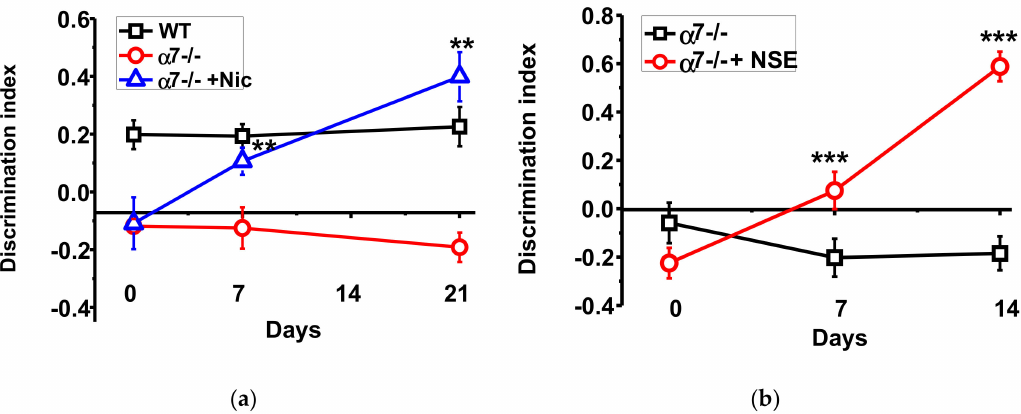
Figure 1. Memory (discrimination index studied in NOR test) of α 7- / - mice under the e ff ect of either nicotine ( a ) or NSE ( b ). Each point on the curve corresponds to M ± SD, n-5. ** p < 0.005; *** p < 0.0005 compared to Day 0 (non-treated mice). WT—wild-type C57Bl